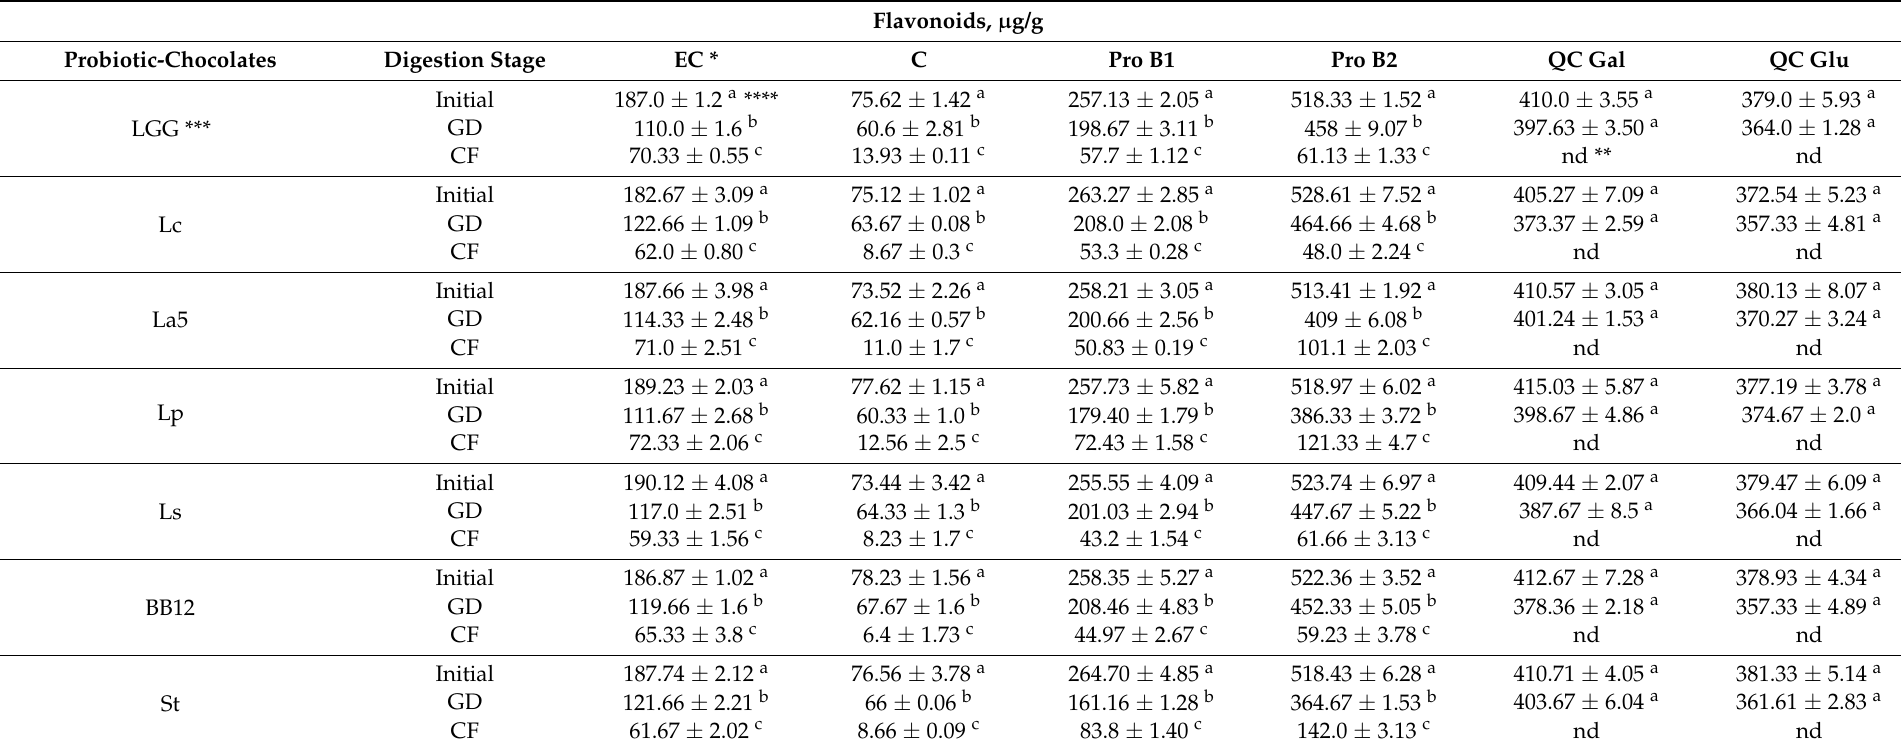
Table 2. Quantitates ( µ g/g) of major flavonoids isolated during in vitro digestion of probiotic-chocolate (45% cocoa powder). Flavonoids, µ